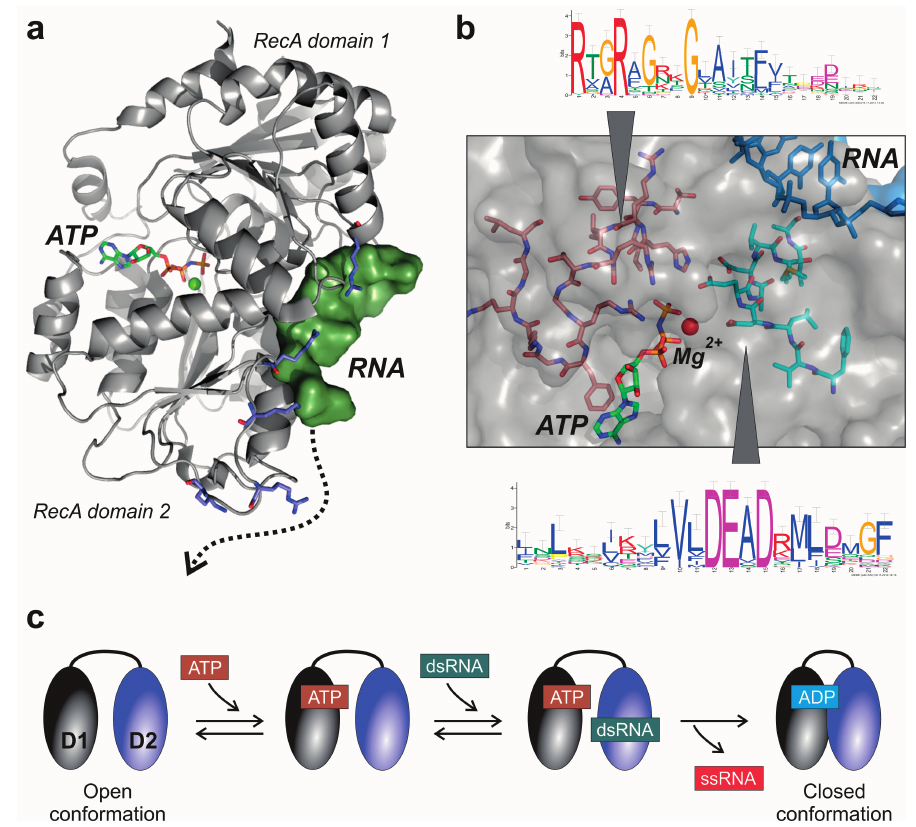
Figure 3. Structural features of the central core of DEAD-box RNA helicases exemplified by the structure of human DDX19B helicase (PDB code: 3G0H). ( a ) Structure of the human DDX19B protein, showing the ATP-binding cleft between both RecA-like domains, and the RNA binding site. The surface close to the RNA binding-site contains a string of positively-charged residues that could support the stabilization of protein-RNA binding along the helicase surface, following the path depicted as a dotted arrow; ( b ) Detailed representation of the location of the DEAD-box linear motif in the core of the DDX19B protein, close to the ATP-binding pocket. The core of the protein also contains an arginine-rich region which is involved in ATP-binding and stabilization of the movements of the RecA-like domains during RNA binding and unwinding; and ( c ) Molecular mechanism of dsRNA unwinding by yeast Mss116p helicase, as proposed from data obtained in X-ray crystallography experiments